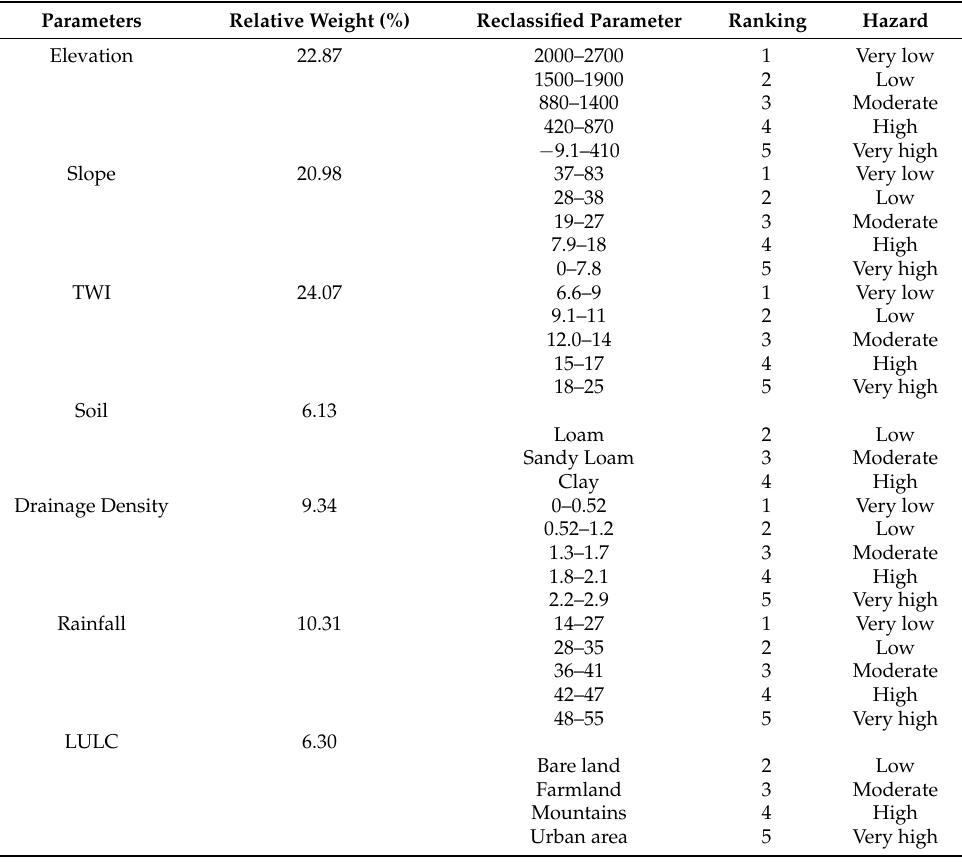
Table 4. Ranking of the watershed’s weighted flooding